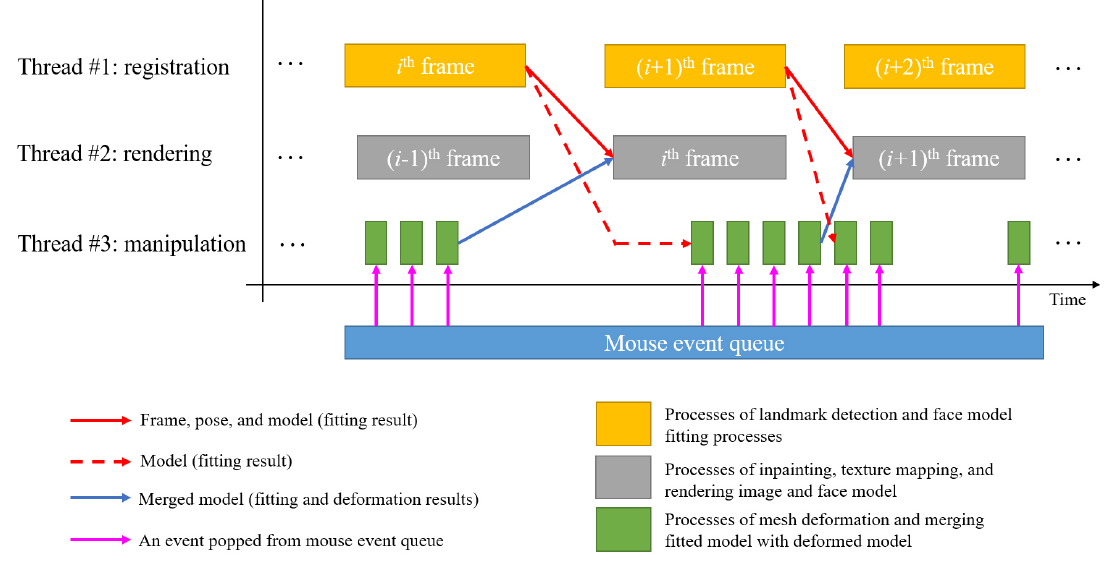
Figure 5. Inter-module parallelization